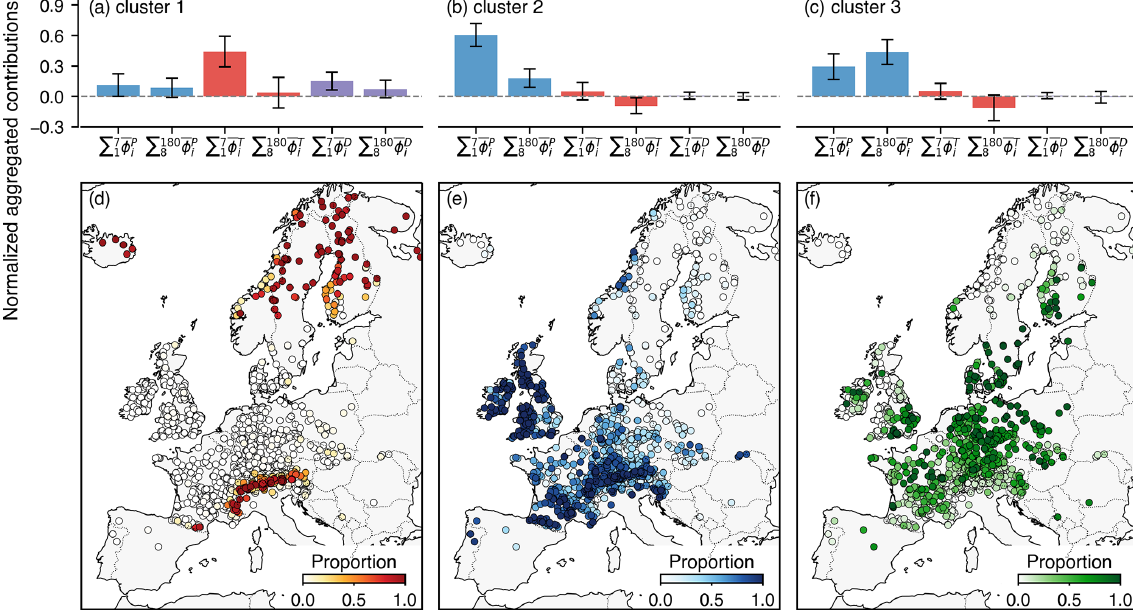
Figure 5. The cluster centroids and variance for the three clusters and their respective proportions of all peak discharge events in each catch- ment. The bars and error bars in (a) – (c) represent the cluster centroids and standard deviations of the six aggregated feature contributions. The proportions in (d) – (f) correspond to clusters 1–3,